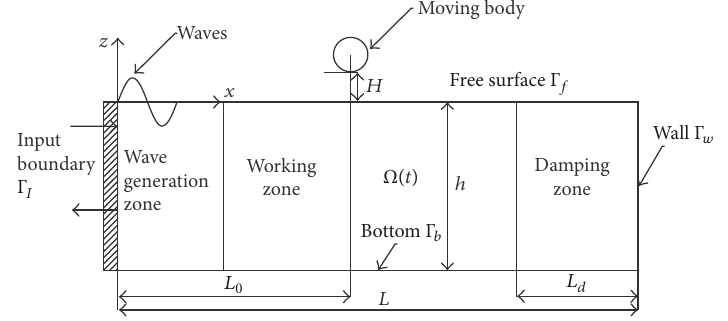
Figure 2: Numerical wave tank and a moving body.